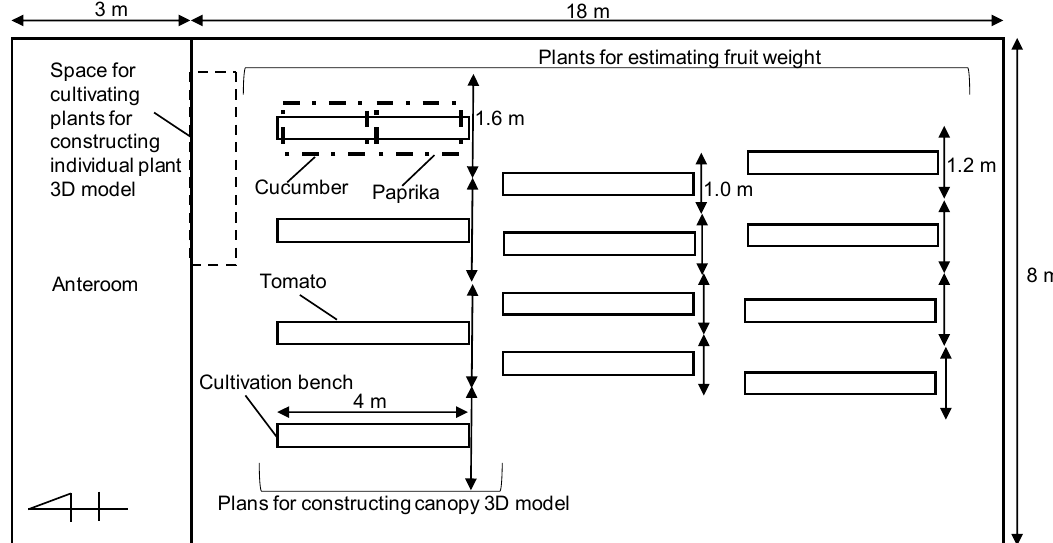
Figure 1. Location of cultivation benches and plants (tomato, cucumber, and paprika) in the greenhouse. The greenhouse was located in Matsudo, Chiba, Japan.